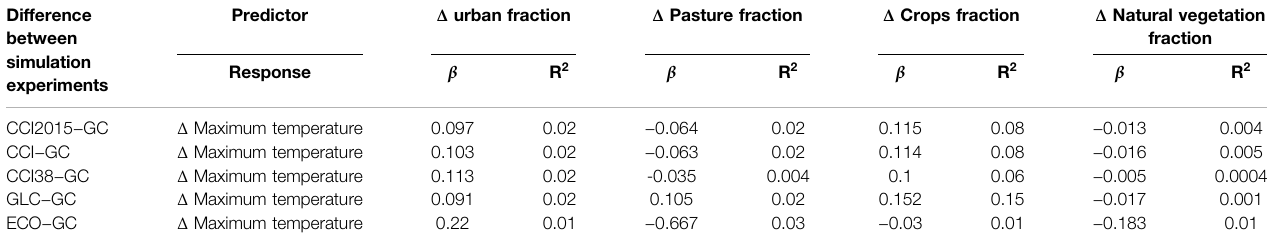
TABLE 3 | Linear regression fi t statistics for coef fi cient β and goodness-of- fi t R 2 values between differences (experiment — control) in urban, pasture, crops and natural vegetationfractionaspredictorsanddifferencesinmaximumtemperatureasresponses.Allregressioncoef fi cientsarestatisticallysigni fi cantat p < 0.05.Thesestatistics are calculated for each simulation experiment. Please see Table 1 for abbreviations of simulation experiments. Analysis is over the vegetation period (April to September). Difference